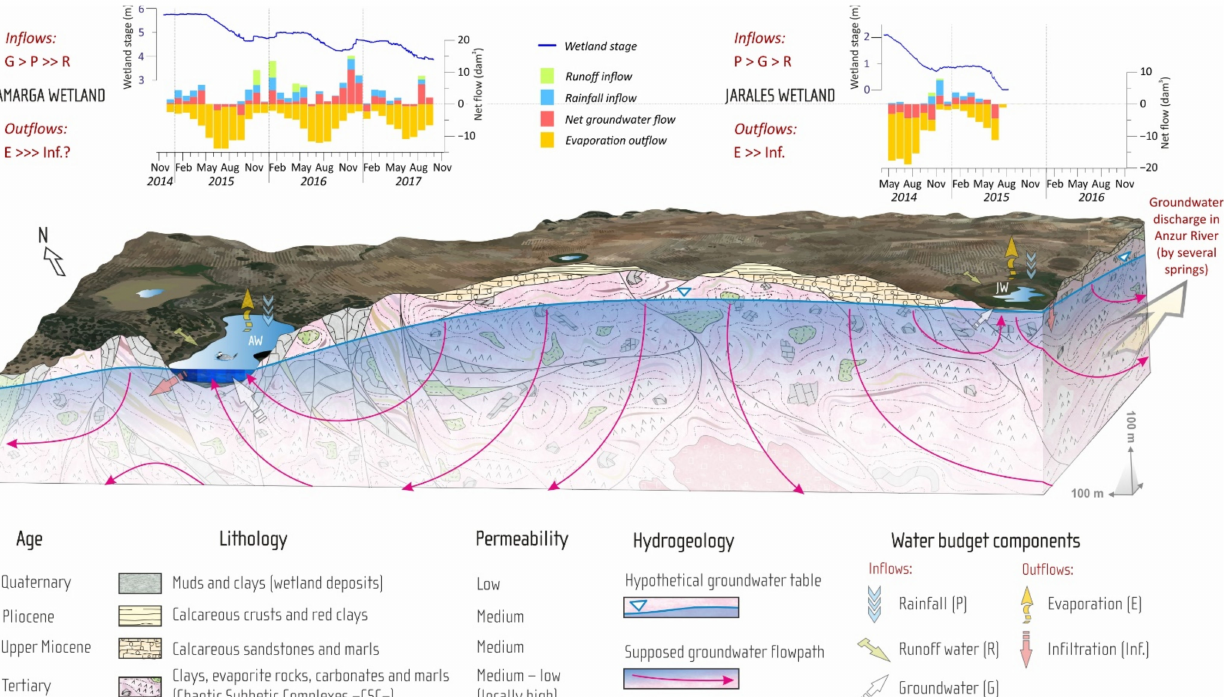
Figure 8. Hydrogeological conceptual model of the Jarales and Amarga wetlands. AW, Amarga wetland; JW, Jarales